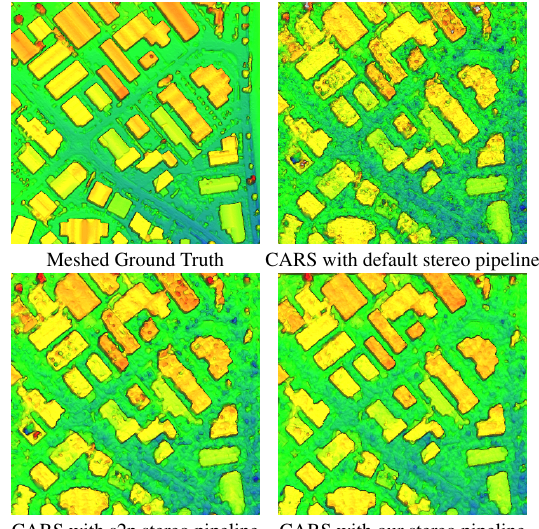
Figure 9. Comparison of meshed DSMs with different stereo matching pipelines. Our method based on MCCNN matching costs and 3SGM optimization with labels from an ARNN provides the best visual